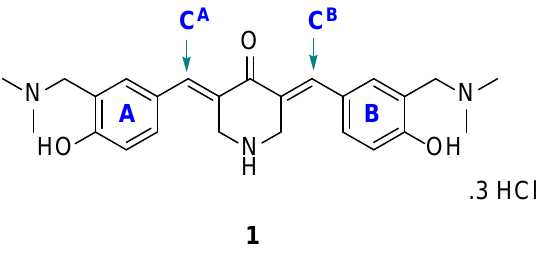
(SI) values (CC 50 figure towards on-malignant cell lines / CC 50 value towards a neoplastic cell line) of 3–7 [4,5].